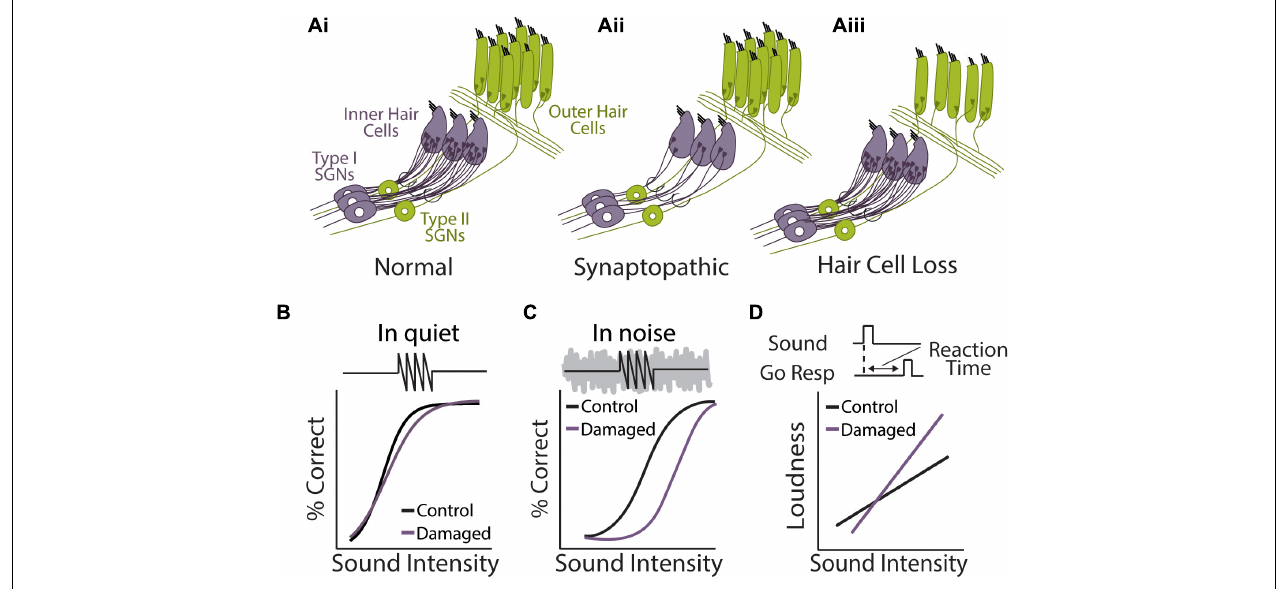
FIGURE 4 | Perceptual consequences of sensorineural hearing loss. (Ai,ii,iii) Diagram of cochlear hair cells and spiral ganglion neuron connectivity under normal (Ai) or pathological conditions of synaptopathy (Aii) , or sensory hair cell damage (Aiii) . (Ai) Purple: over 95% of afferent input to central auditory system comes from type 1 spiral ganglion neurons (SGN) that form synaptic contacts inner hair cells (IHCs), the main conventional sensory receptors of the cochlea. IHCs are innervated by multiple (10–20) type I neurons but each type I neuron only contacts a single IHC. Green: unmyelinated type II SGNs form synaptic contacts with multiple outer hair cells (OHCs) but each OHC only receives one contact from one Type-II neuron. Type-II SGNs represent only 5% of afferent input and are not involved with transmission of acoustic information to brain. Rather, the major role of OHCs is to amplify the cochlear mechanical response to low-level input, providing increased sensitivity to low intensity sounds. (Aii) In the synaptopathic ear, many of the synaptic contacts between type I SGNs and IHCs have degenerated, leaving fewer afferent nerve fibers to relay sound information from the ear to the brain, which may underly hidden hearing loss and impaired speech-in-noise perception. (Aiii) Many forms of acquired sensorineural hearing loss are associated with damage to OHCs and disruption to mechanical cochlear gain control mechanisms, leading to permanent threshold shifts, loudness recruitment, and broader frequency tuning. (B) Tone detection behavior in animals with selective damage the type I SGN-IHC complex (purple) is remarkably normal under quiet conditions, even with moderate to severe cochlear deafferentation. (C) Tone-in-noise detection is more severely impaired in animals with selective damage the type I SGN-IHC complex (purple) even though thresholds in quiet are maintained. Schematized data in panels (B,C) adapted from Resnik and Polley (2021). (D) Auditory reaction time (RT) measures of loudness growth in animal models (Radziwon and Salvi, 2020) have demonstrated that some forms of hearing loss can result in abnormal increases to the slope of RT-intensity functions, consistent with loudness recruitment and/or